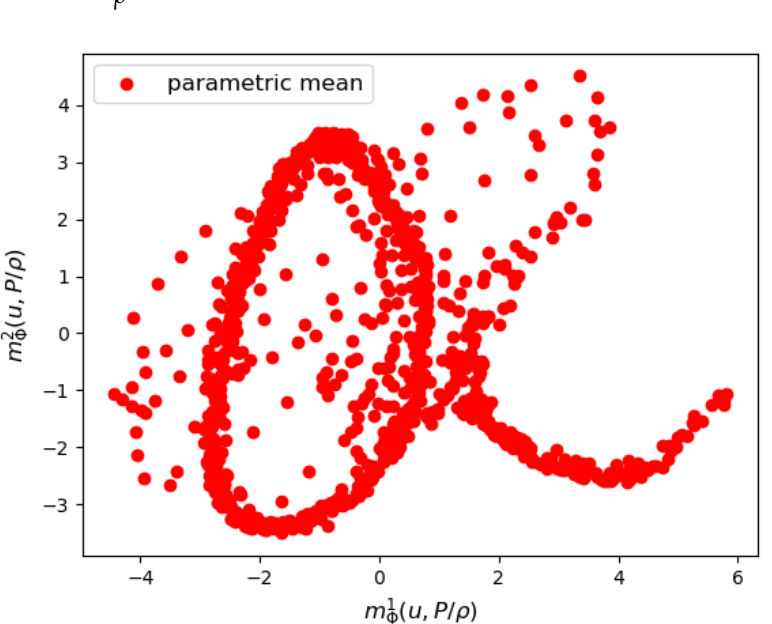
Figure 11. Mesh n°2: The first two components of the parametrized mean of the VAE encoder.